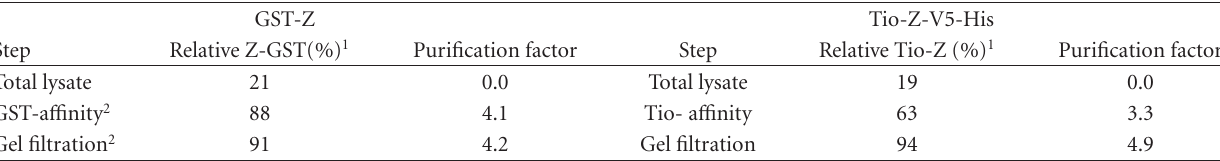
1 Soluble protein ratio (Z fussion protein/total protein). 2 Include degradation products of